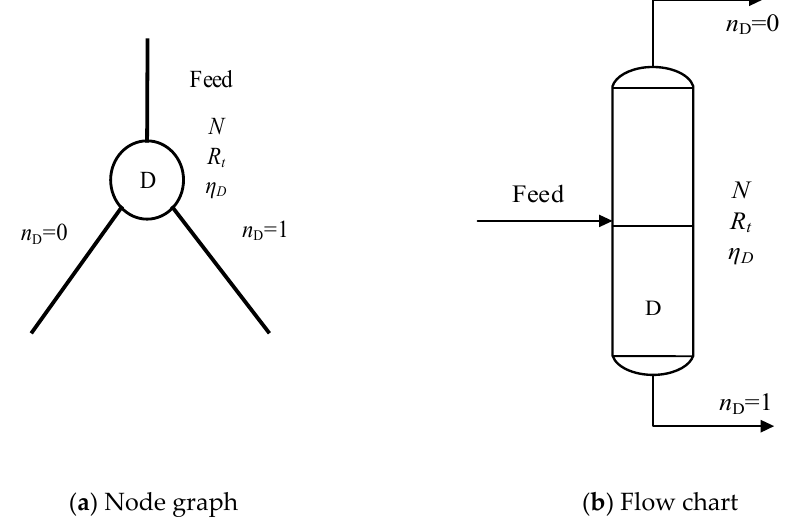
Figure 1. Distillation column node graph ( a ) and distillation module flow chart ( b ) obtained by decoding.